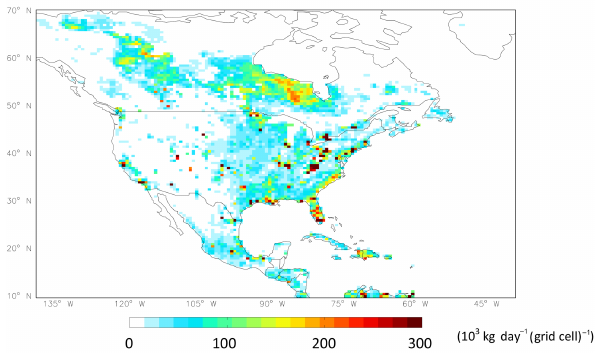
Figure 1. Total daily average prior methane emissions for the nested North America domain (0 . 5 ◦ × 0 . 7 ◦